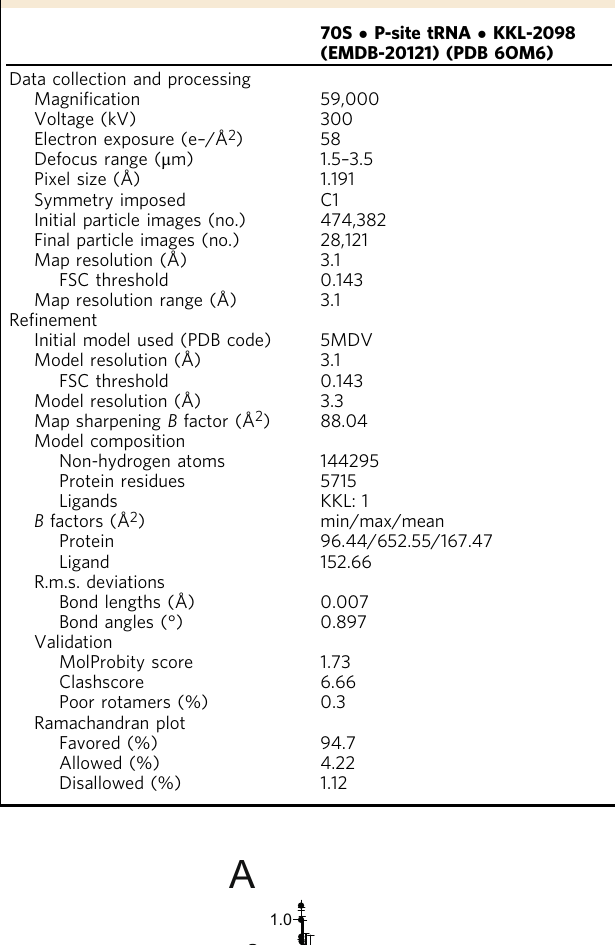
Table 1 Cryo-EM data collection, re fi nement and validation